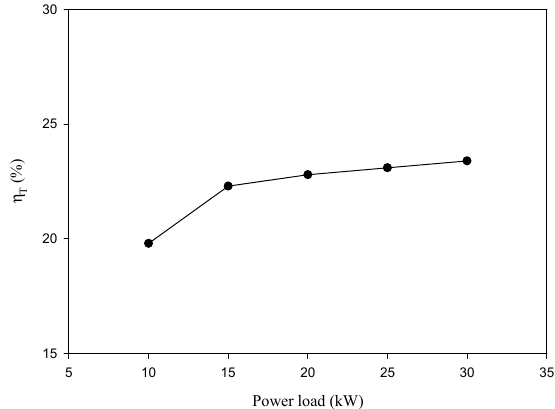
Figure 2. Thermal efficiency ( η T ) vs. rated power load (P WL ) for micro gas turbine electricity generator using biogas for test operation.